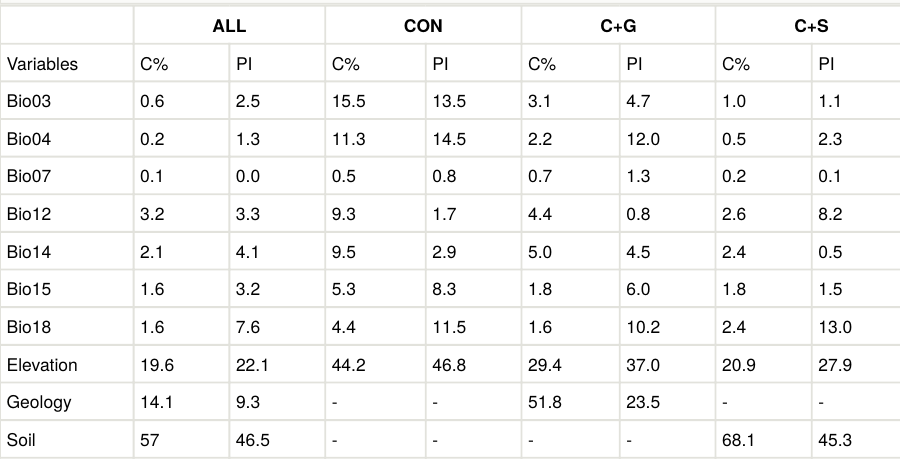
combinations of variables and thresholds performed di ff erentially better (Fig. 3): ALL + Equal training sensitivity and speci fi city logistic threshold and C+S + Maximum training sensitivity plus speci fi city logistic